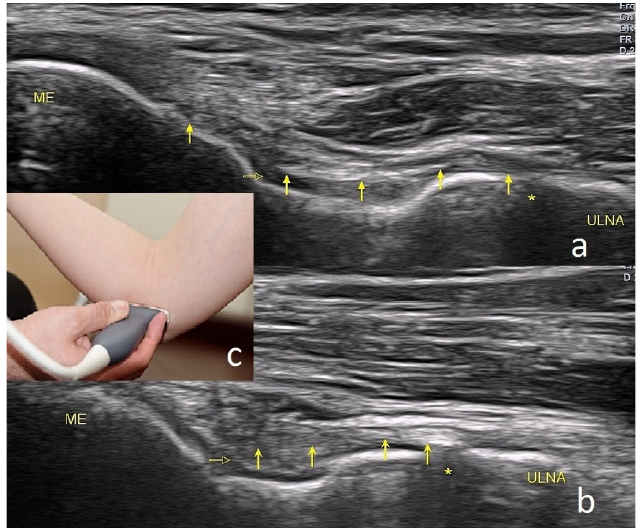
Figure 4. Image of the anterior part of the medial collateral ligament. ( a )—During flexion, ( b )—during extension, ( c )—positioning of the probe; ME—medial epicondyle; arrows—the ligament; open horizontal arrow—joint capsule level; asterisk—the joint gap. Healthcare 2022 , 10 , x